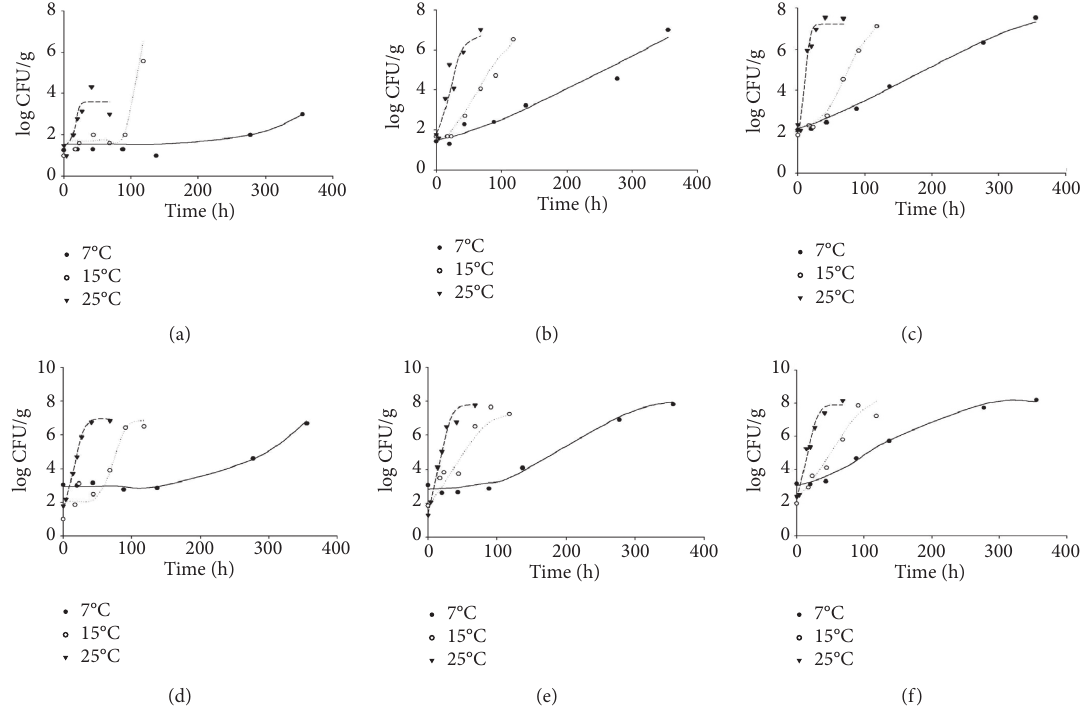
Figure 1: Growth of L . monocytogenes in rice balls by fitting the Baranyi model: tuna rice balls mixed with mayonnaise (a), soy sauce (b), and gochujang (c) and ham rice balls mixed with mayonnaise (d), soy sauce (e), and gochujang (f). Symbols, experimental data; line, fitted